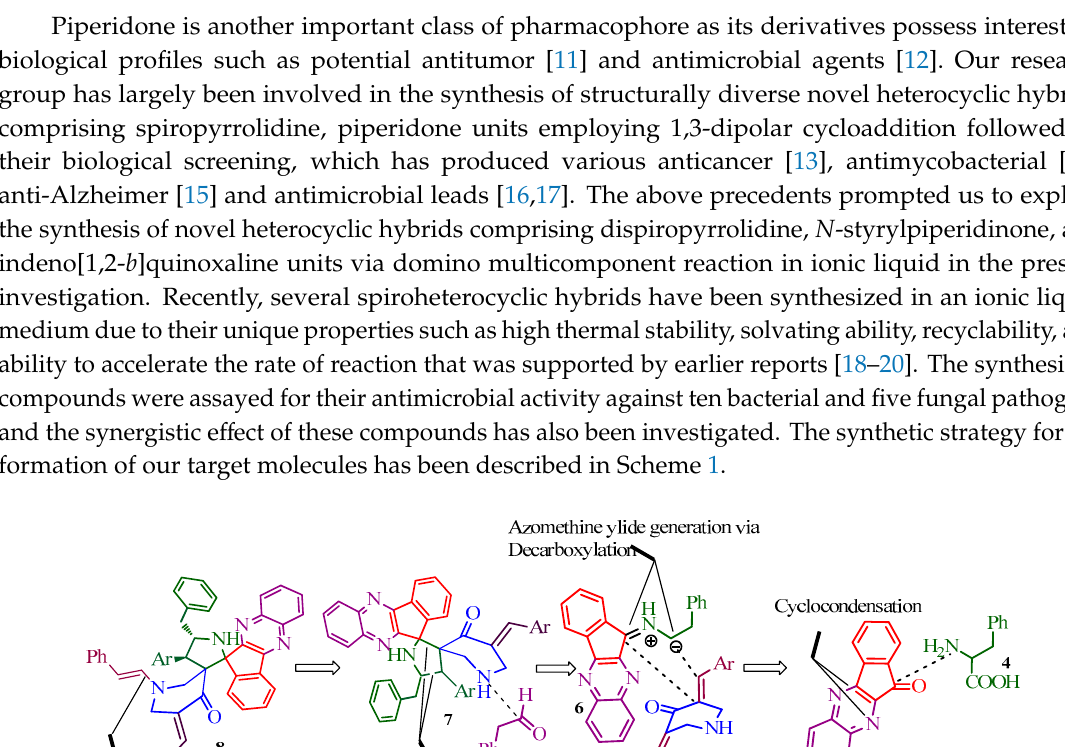
Figure 1. Biologically important spiropyrrolidine heterocycles.